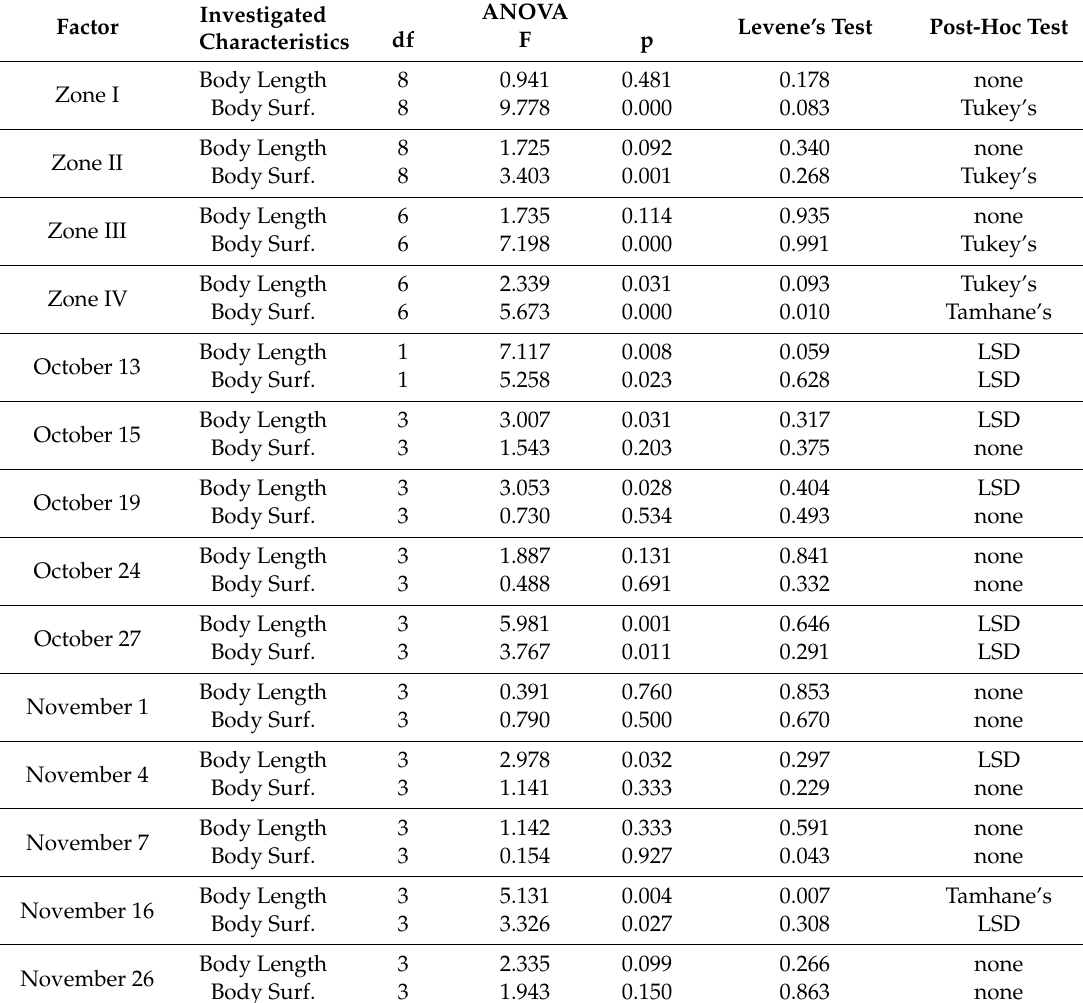
Table A1. Details of the statistical